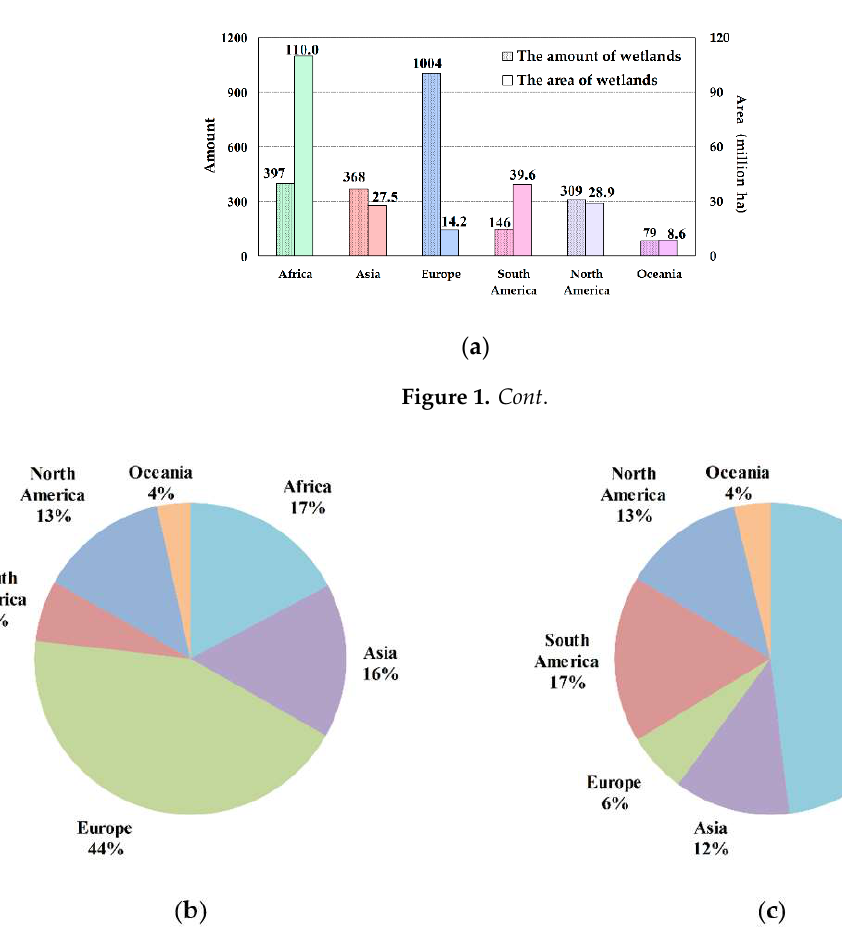
Figure 1. The amount and area ( a ), amount ratio ( b ), and area ratio ( c ) of the Ramsar Sites in